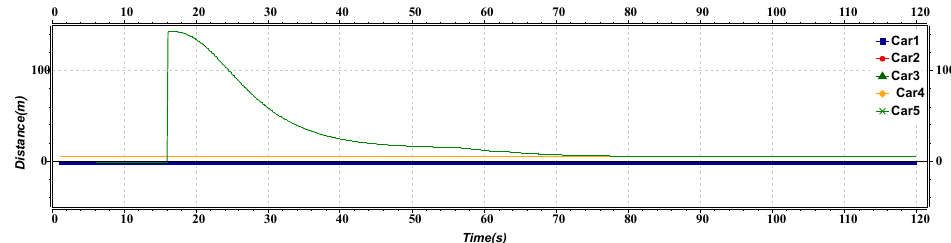
Figure 9. Distance versus time graph of joining